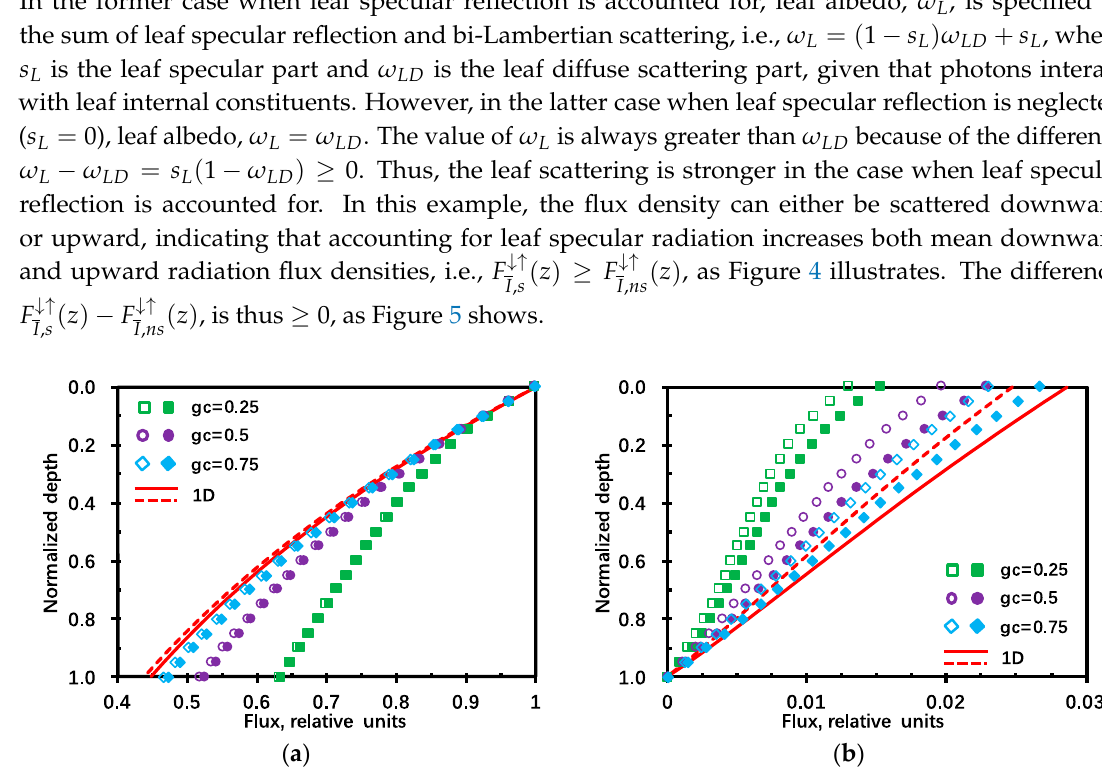
Figure 4. Vertical profiles of mean downward ( a ) and upward ( b ) radiation flux densities over the entire horizontal plane at red band for four types of ground cover conditions. The 1D vegetation canopy (“1D”) represents the case when ground cover is unity, i.e., gc = 1.0. Solid symbols and lines correspond to the mean radiation flux densities when leaf specular reflection is accounted for, whereas hollow symbols and dashed lines denote that when leaves are bi-Lambertian scatters. The canopy is bounded from below by a non-reflecting background. Canopy LAI is constant and equals 1.5. Plant LAI varies with ground cover as 1.5/ gc . The vertical axis shows the normalized depth, which is defined as z / H were H is the canopy depth.